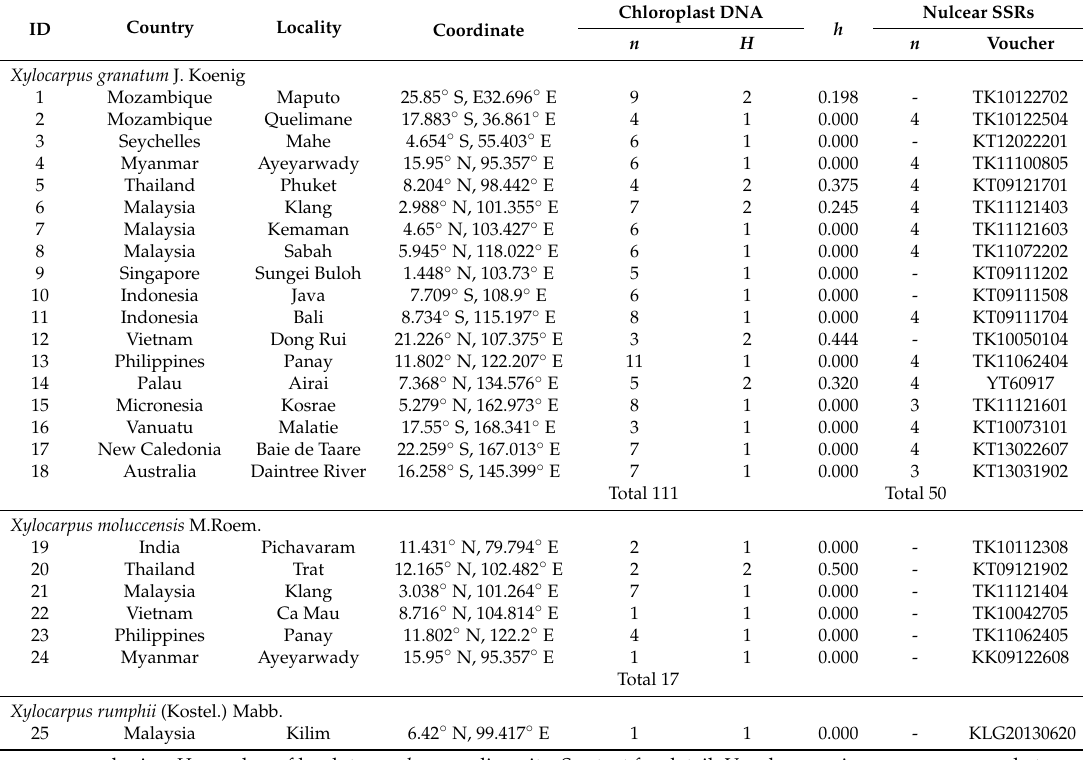
Table 1. Information of population samples used in this study.